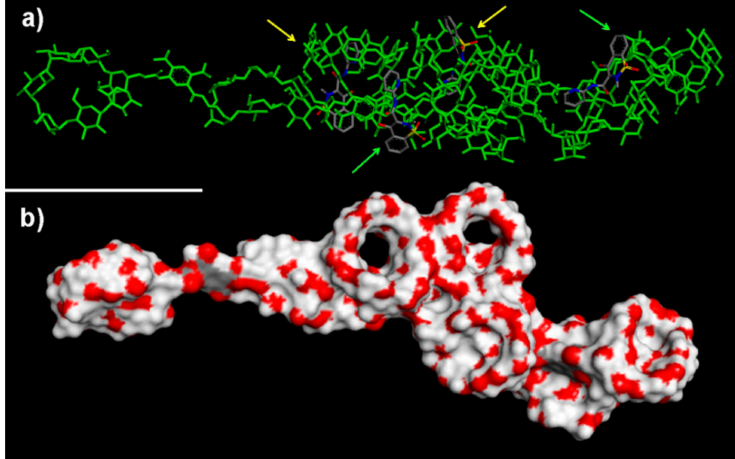
Figure 7. Panel ( a ) shows the optimized geometry assumed by the NS / 4 PX molecules system at the end of the MD run displaying two included molecules in a 1:1 stoichiometry (see the yellow arrows) and two PX molecules interacting on the external surface of the NS model. The NS is in green for clarity and the PX molecules are colored by atoms, see the color codes in Figure 3. Panel ( b ) shows the solvent-accessible surface area without the PX molecules for clarity (see the color codes in Figure